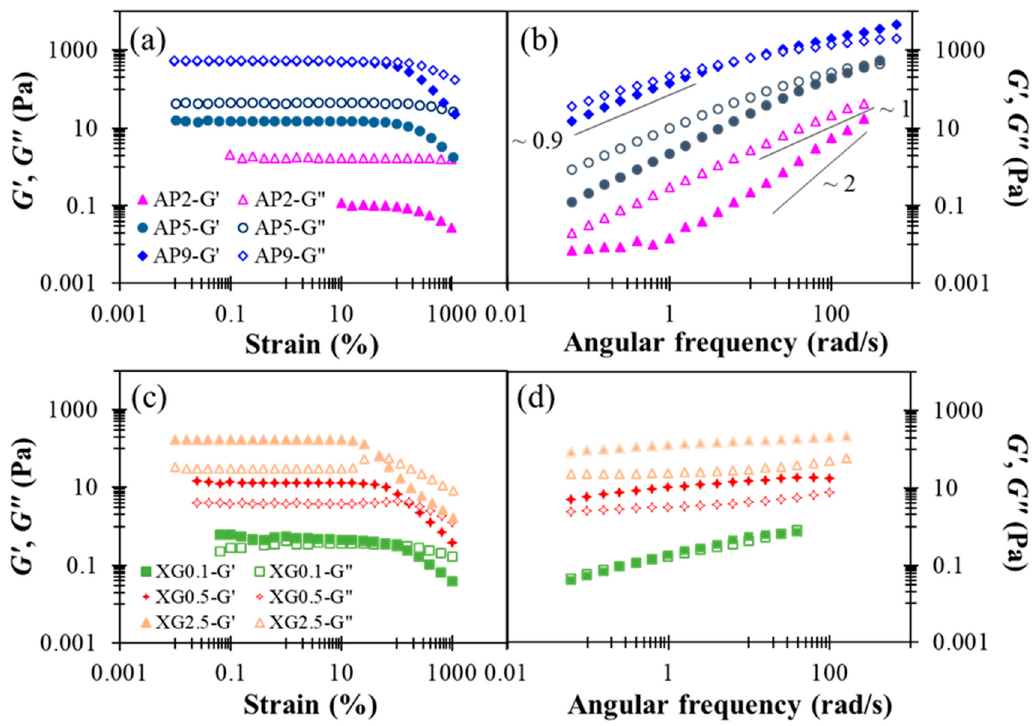
Figure 2. Concentration dependent shear storage modulus (G’) and loss (G”) modulus profiles with respect to percentage strain and angular frequency alterations as for sole thickeners: ( a ) strain sweep of AP, ( b ) frequency sweep of AP, ( c ) strain sweep of XG, ( d ) frequency sweep of XG.